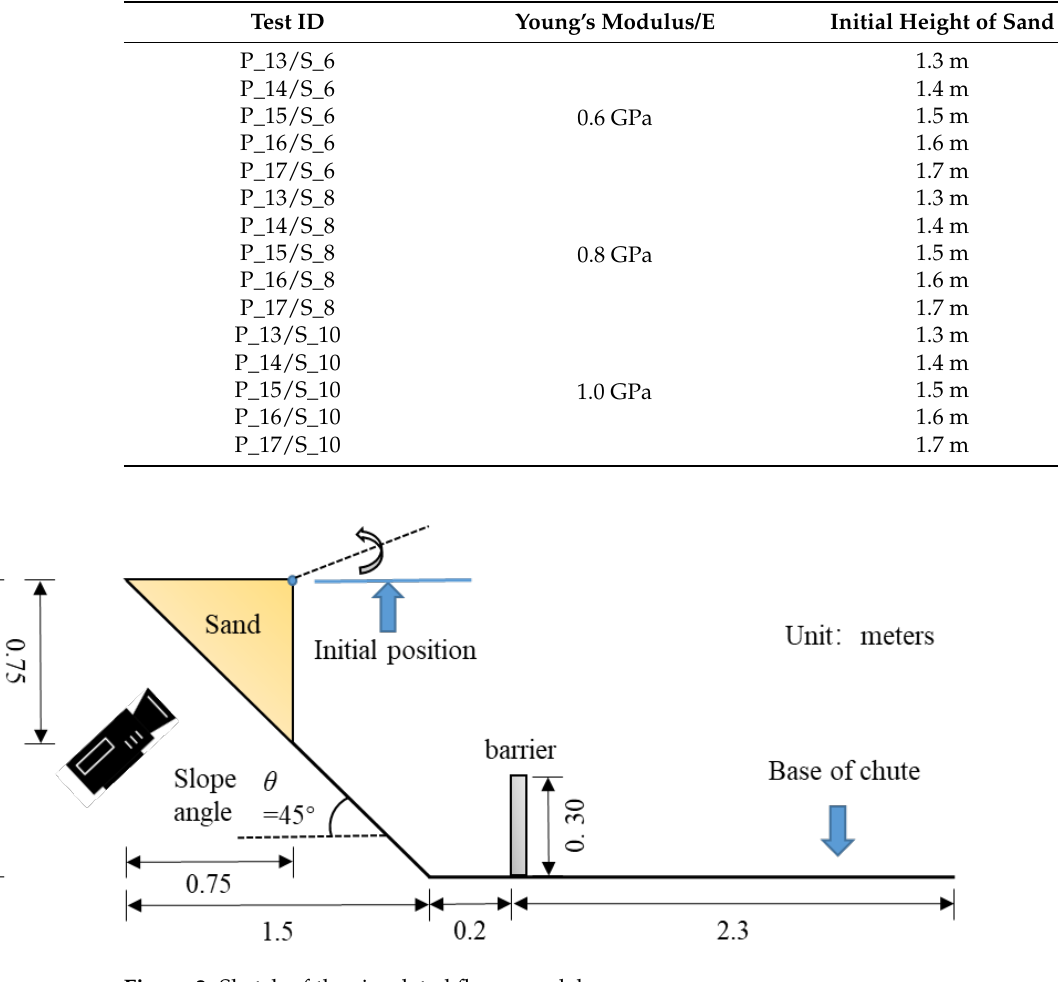
Table 2. Numerical simulation program.